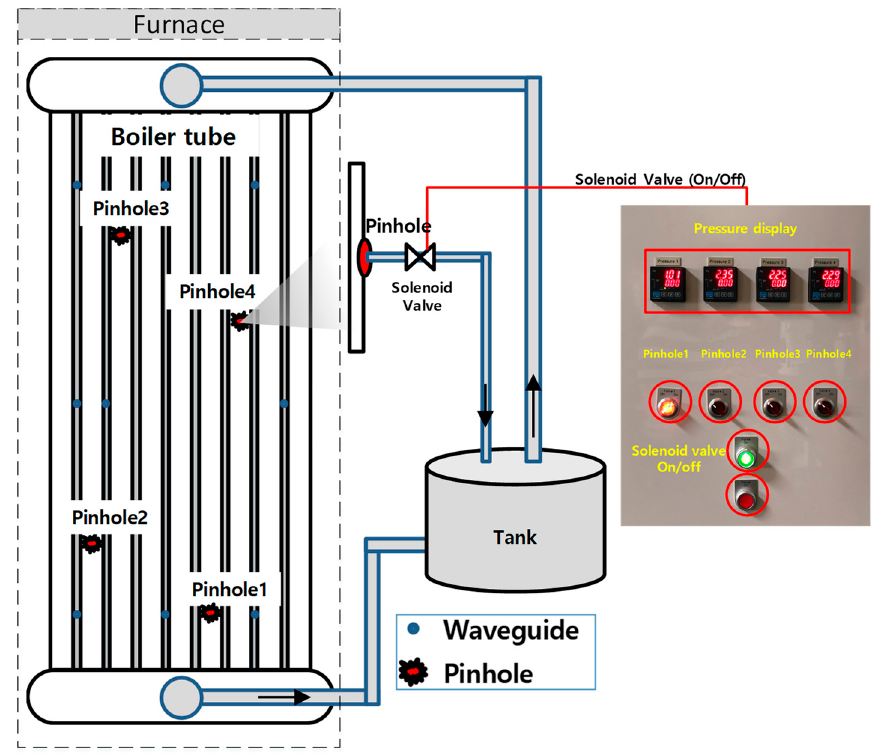
Figure 1. The overall scheme of the boiler tube leak detection testbed.